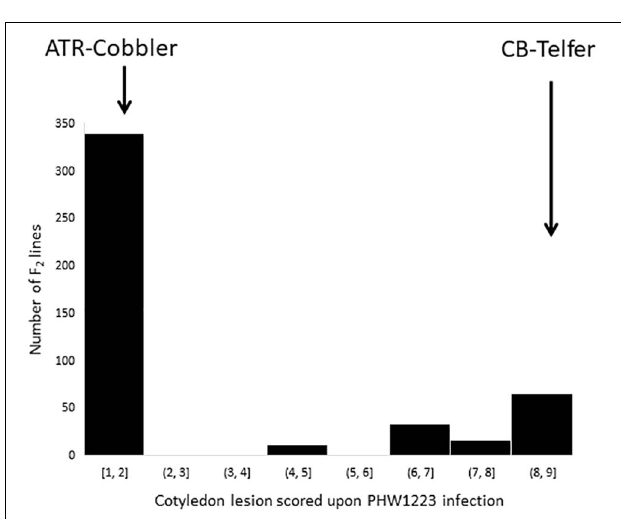
FIGURE 1 | Infection response of parental lines CB-Telfer (maternal, Rlm4 ) and ATR-Cobbler (paternal, Rlm4 and Rlm9 ) to the L. maculans isolate PHW1223 ( AvrLm5-6-8-9-S ). The visible symptoms of blackleg commenced after 7–10 days of inoculation. Resistant parental and intercross lines displayed a limited cotyledon lesion compared to susceptible lines, which displayed extensive cotyledon lesions, characterized by discoloration and pyncindia sporulation (after 21 days of inoculation).